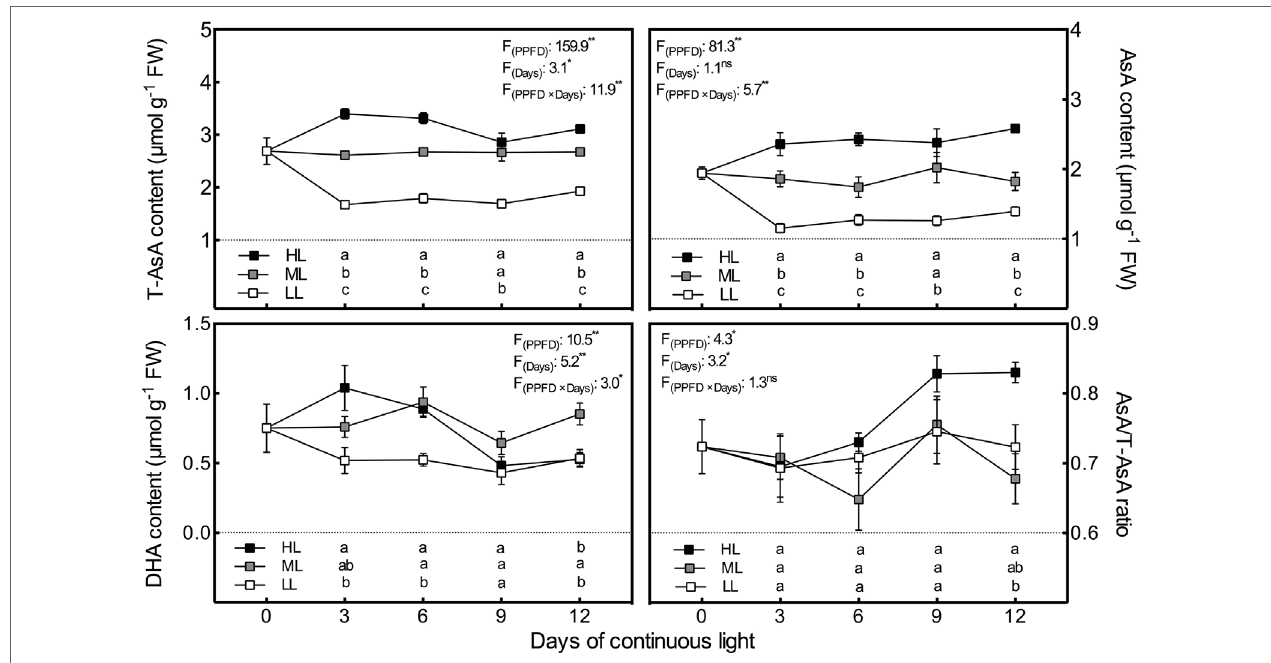
FIgURe 2 | Changes in total ascorbate (T-AsA), ascorbate (AsA) and dehydroascorbate (DHA) contents as well as AsA/T-AsA ratio in lettuce leaves grown under continuous light of different intensities: low light (LL, 100 μmol·m −2 ·s −1 ), medium light (ML, 200 μmol·m −2 ·s −1 ), and high light (HL, 300 μmol·m −2 ·s −1 ). Values are means of four replicates ± SD. Different letters indicate significant differences between different light intensity treatments at p < 0.05 according to Tukey test. F values and significance of the two-way ANOVA considering the factors light intensity (PPFD), days and their interactions were given in the inset. ns , * and ** indicate nonsignificant and significant at p < 0.05 and 0.01 respectively.